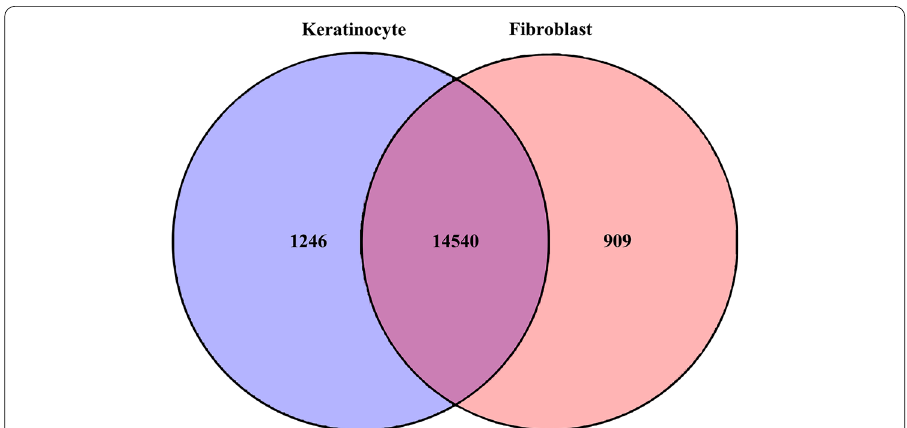
Fig. 2 Summary of the numbers of differentially expressed genes. Venn diagram showing the number of genes shared and unique to each cell